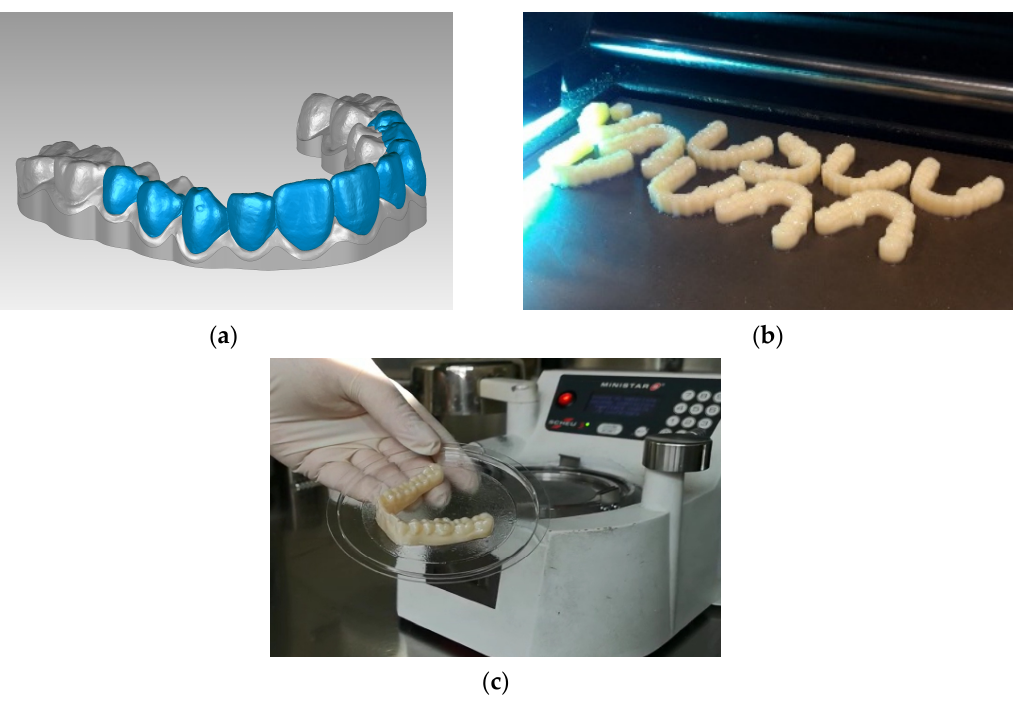
Figure 1. Phases of the digital process for the production of the customized dental trays: design of the reference model ( a ), 3D printing of the reference model ( b ), and thermoforming of the dental tray ( c ).